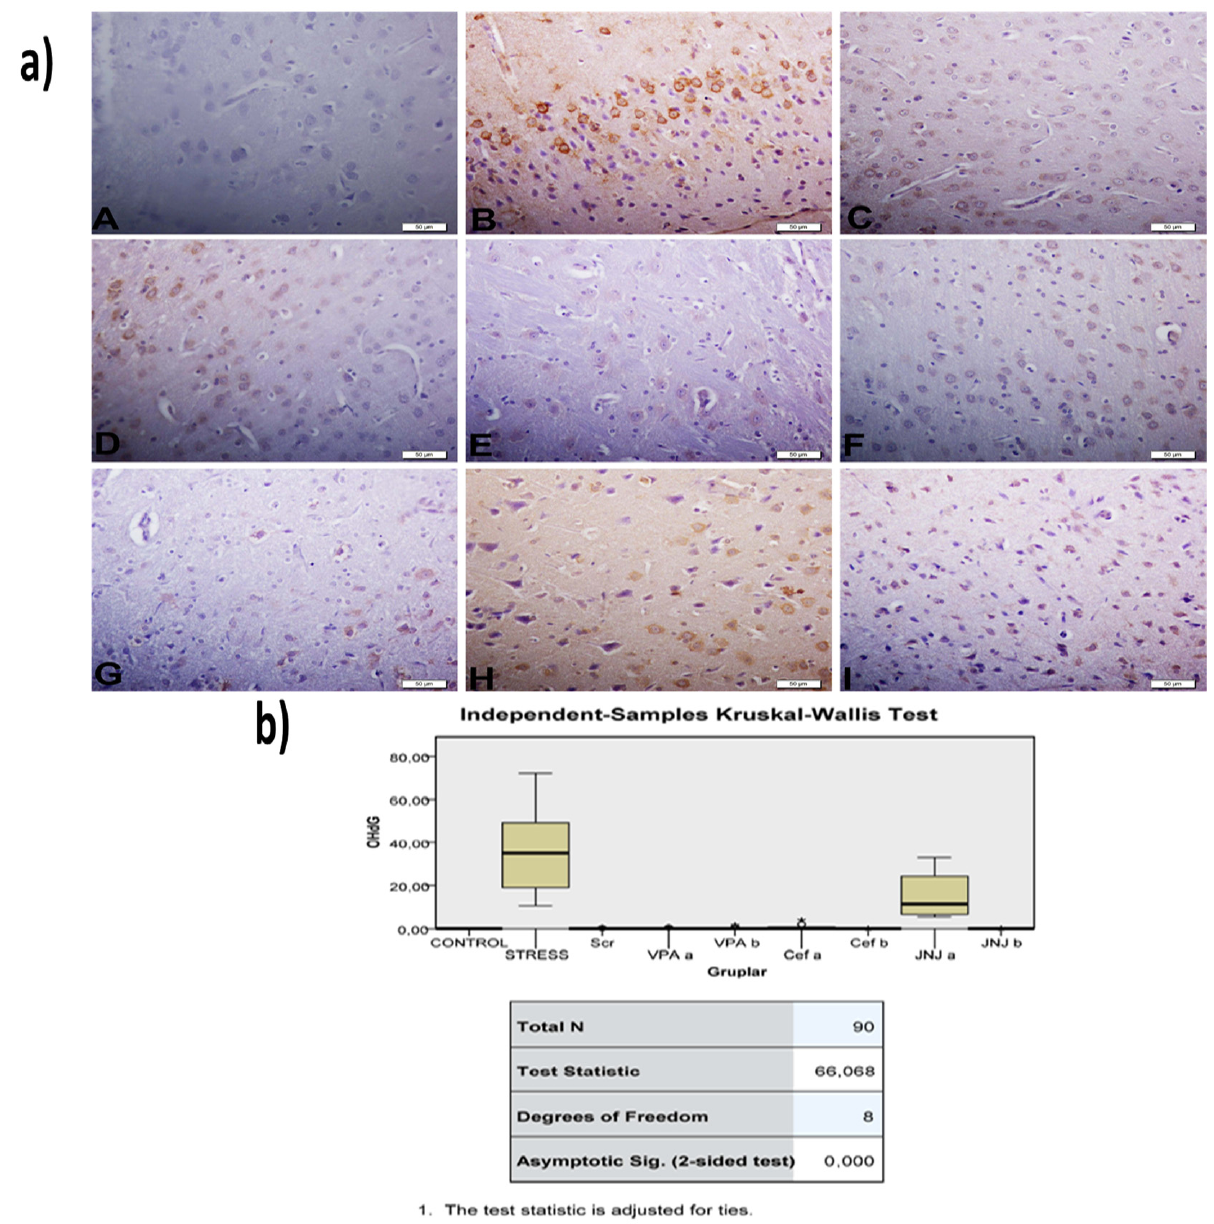
Figure 7. ( a ) 8-OHdG images of experimental groups. Histopathological images of A (Control), B (Stress), C (Ser), D (VPAa), E (VPAb), F (Cefa), G(Cefb), H (JNJa), and I (JNJb). IHC-P—immunohistochemistry-paraffin protocol. ( b ) Quantitative analysis of IHC, immunofluorescence staining, and mean immunoreactivity intensity was determined using ImageJ software (ImageJ). p < 0.05 was considered statistically significant.